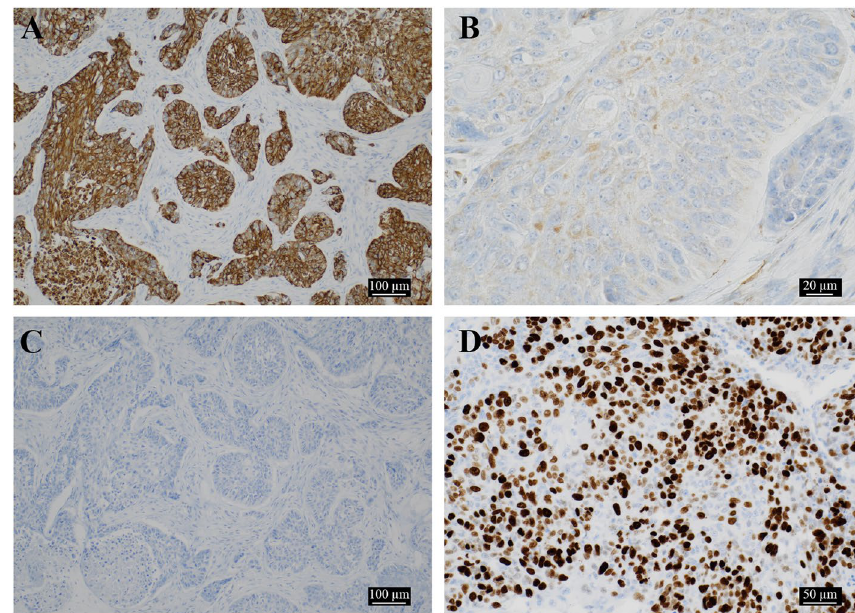
Fig. 10 Immunohistochemical evaluation. a Cytokeratin 19 is positive ( ( 100). d Many tumor cells are positive for Ki-67 ( ×